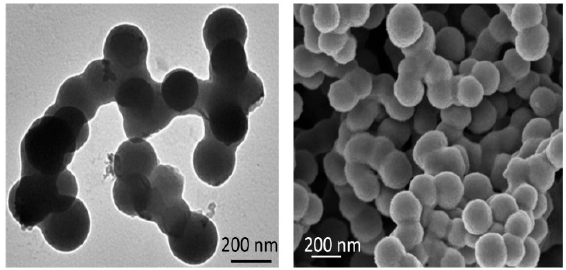
Figure 4. Detailed view of the black carbon samples used for a controlled exposure: Transmission ( left ) and scanning ( right ) electron microscope image.